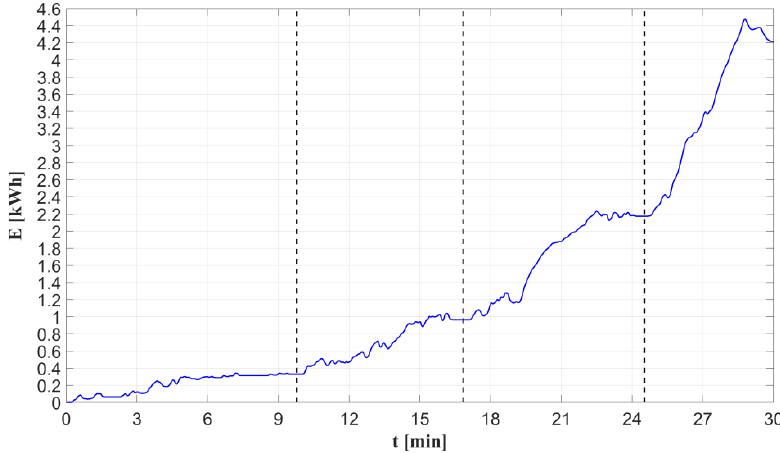
Figure 17. WLTP driving cycle energy consumption.